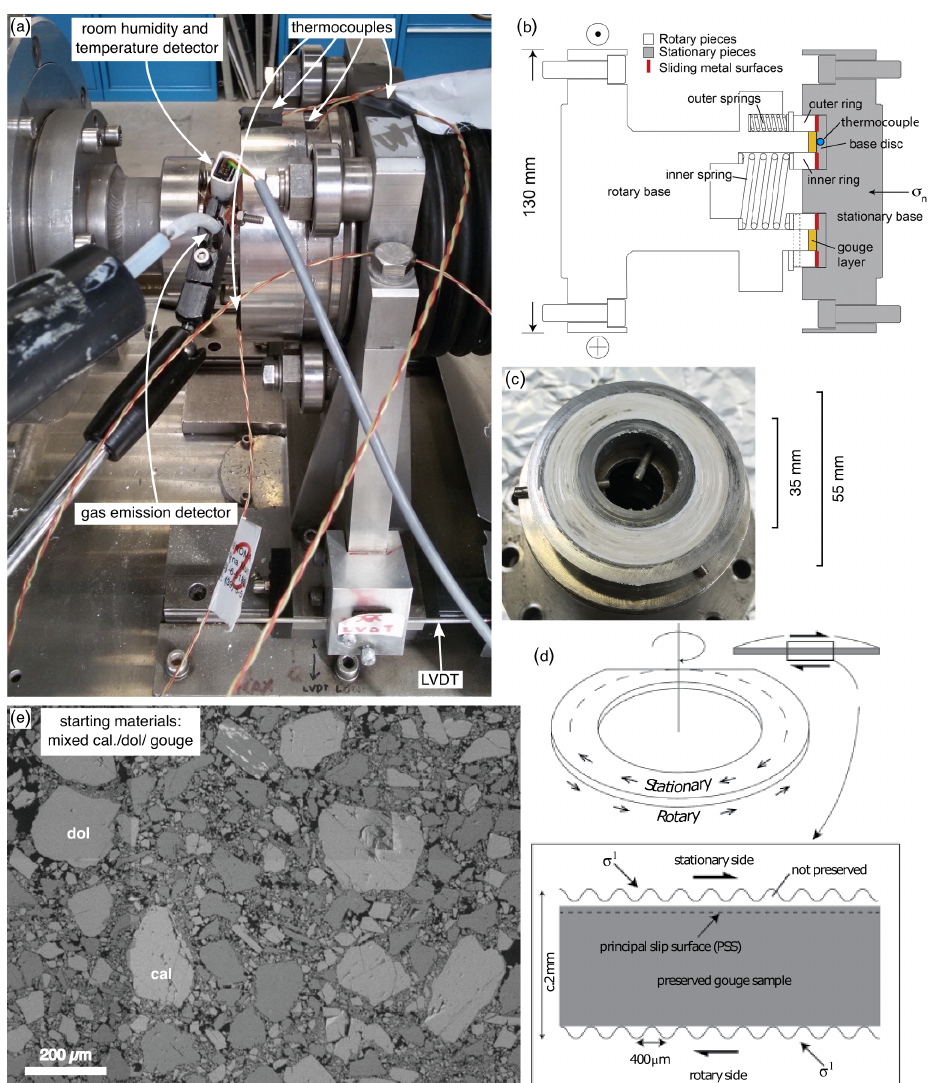
Figure 1. Rotary-shear experimental setup. (a) Detectors in the sample chamber. Gas emission, humidity, and temperature detectors were placed at < 1cm from the sample holder. Four thermocouples were placed on the stationary side at increasing distances from the gouge layer. Note that the position of the thermocouple nearest to the gouge layer is not visible here and is illustrated in (b) . (b) Diagram of the gouge holder with the location of the thermocouple nearest to the gouge layer (modified following Smith et al., 2015). (c) Sample appearance post-deformation with mirror-like slip surface formed in an experiment performed at V = 0 . 1ms − 1 . (d) Diagram showing the location of the recovered and analysed gouge layer after the experiment (following Smith et al., 2017). (e) SEM backscattered electron (SEM-BSE) image of the starting material after applying 17.5MPa for